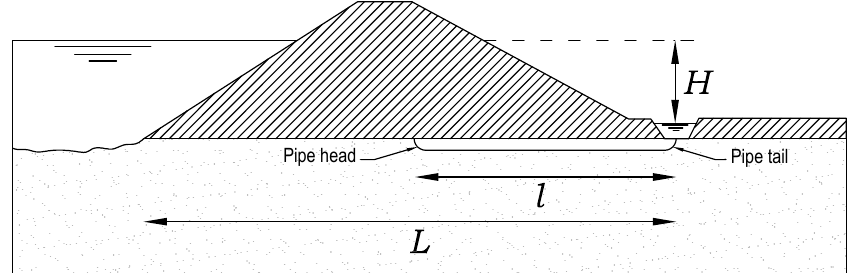
Figure 1. Backward erosion piping under a dike (adapted from ICOLD,